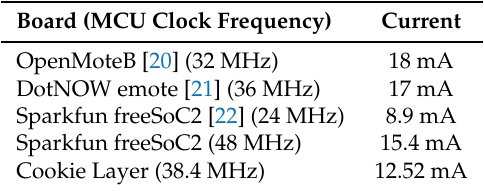
Table 3. Current consumption comparison for the different Edge nodes.